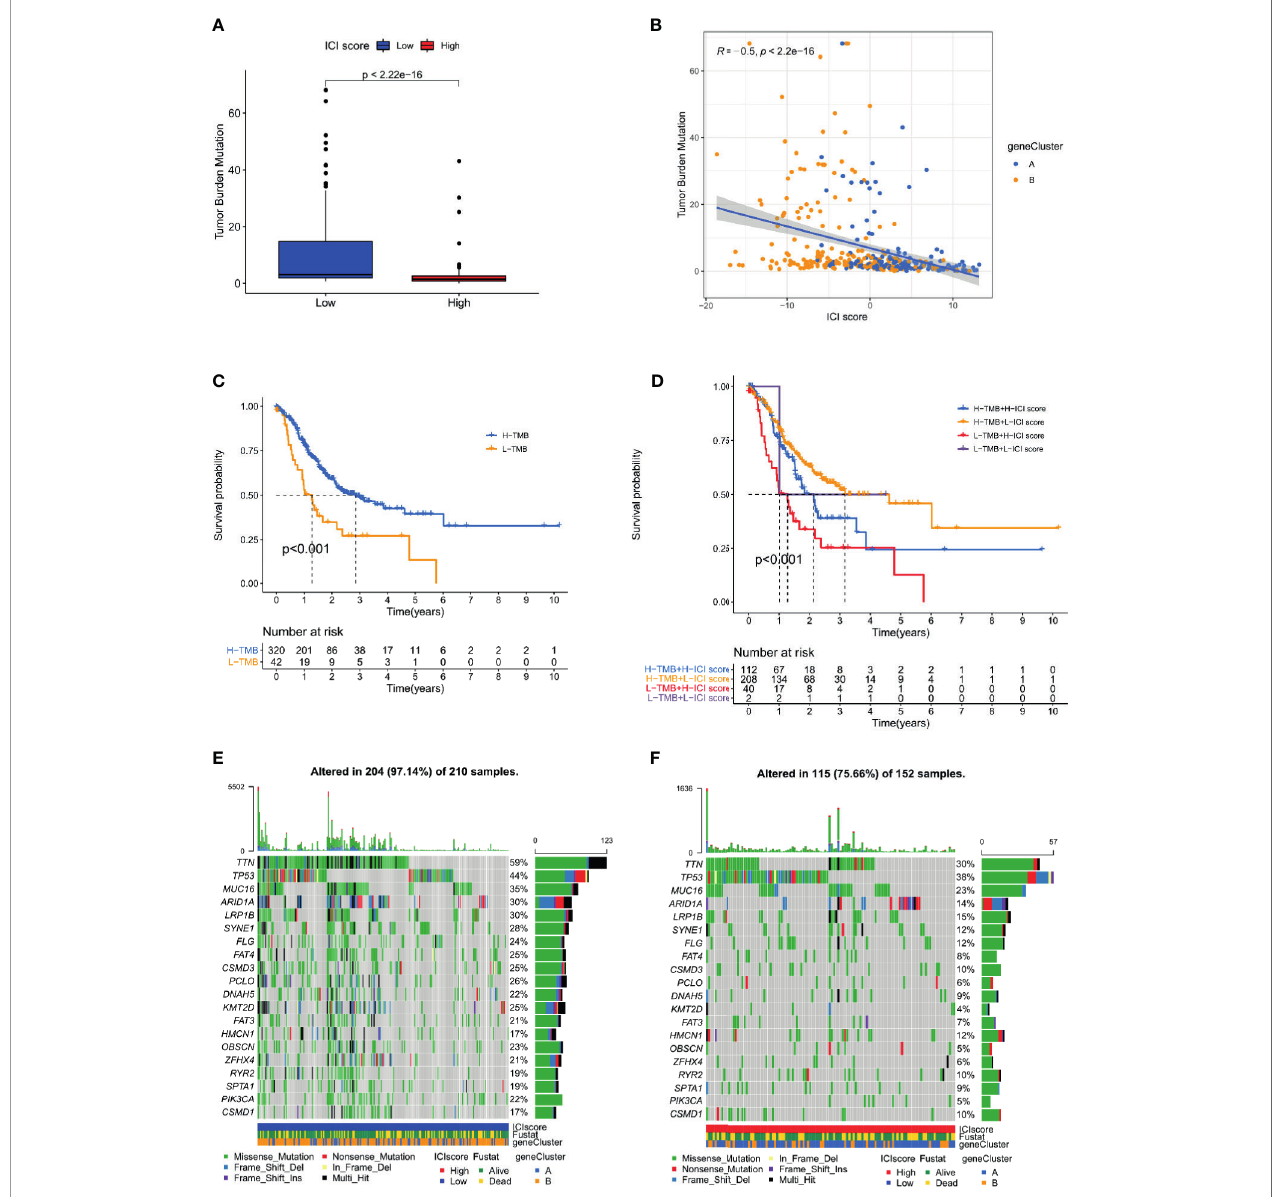
FIGURE 5 | The interrelations between the ICI score and somatic mutation variants (SNVs) (A) Tumor mutation burden (TMB) variations between the high and low ICI score groups. (Wilcoxon test, p < 0.0001) (B) The positive correlation between ICI scores and mutation load in TCGA-STAD cohort was shown by scatterplots. (Spearman text, p < 0.0001). (C) The log rank test shown by Kaplan-Meier curves indicated a better overall survival for high TMB score groups. (p < 0.001). (D) The combination of TMB and ICI score helped predict the overall survival. (E, F) The SNVs spectrum was constructed based on different ICI scores clusters, blue for low and red for